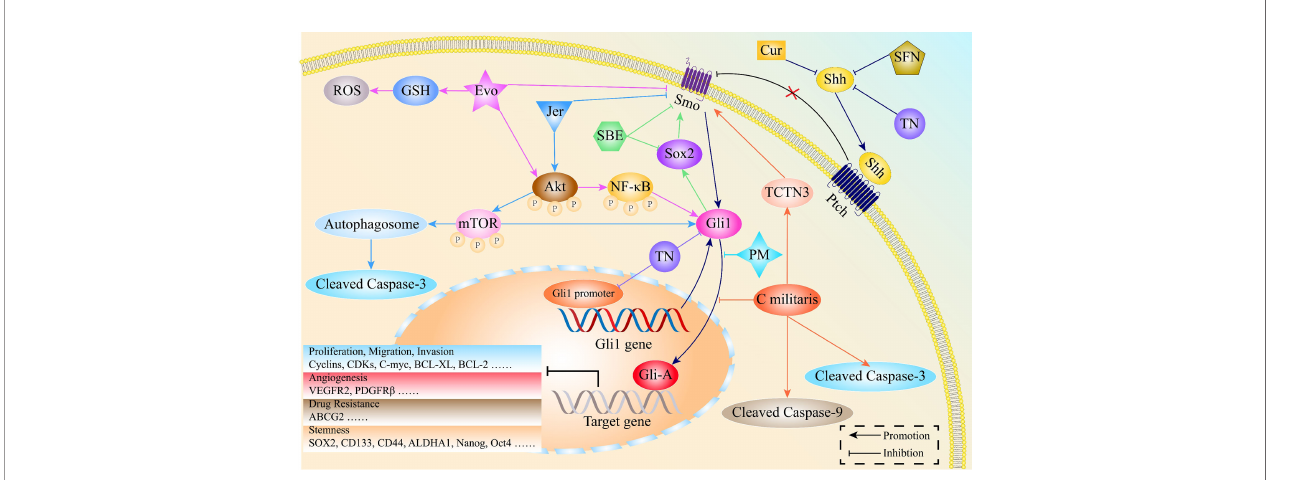
FIGURE 6 | The mechanisms through which natural products exert potent anti-cancer activities by regulating the HH pathway in lung cancer. Jervine (Jer), Evodiamine (Evo), Scutellariabarbata D. Don extraction (SBE), Sulforaphane (SFN), Triptonide (TN), Curcumin (Cur), Pristimerin (PM), Cordyceps militaris Exerts (C militaris), Tectonic protein 3